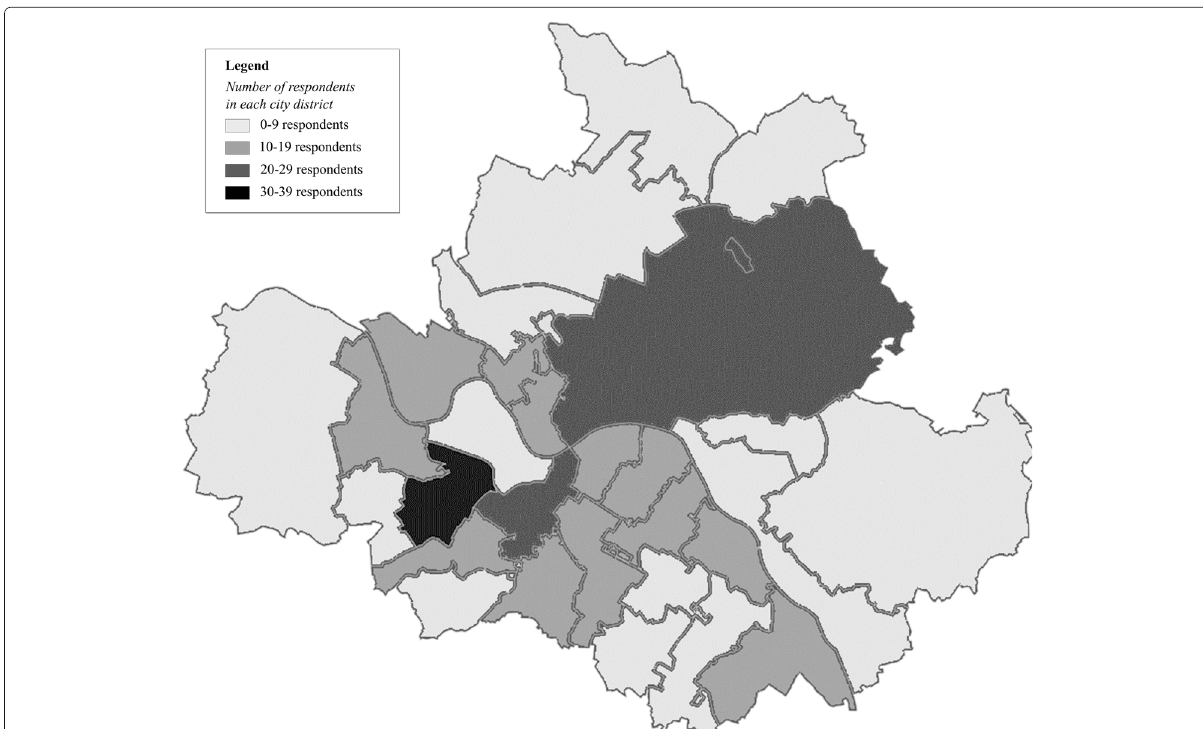
Fig. 3 Residential areas of